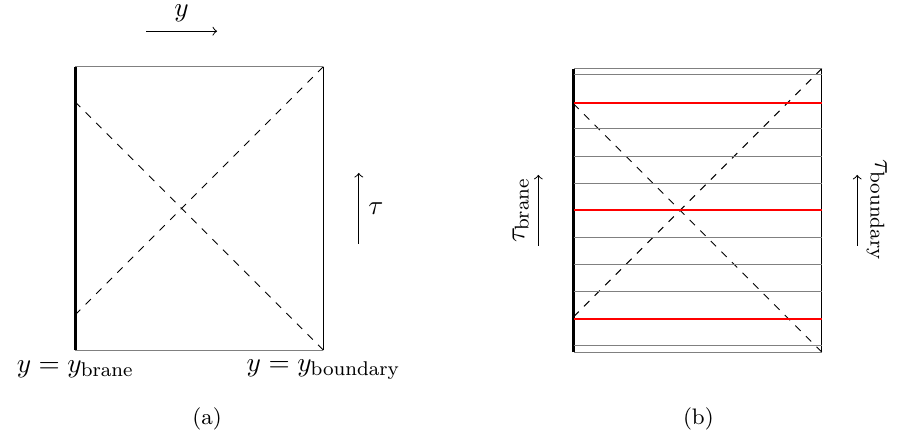
Figure 4 . The Penrose diagram for an AdS 3 black hole microstate with an embedded ETW brane. (a) The asymptotic boundary is located on the right. The ETW brane cuts off the geometry on the left. Horizons are represented by dashed lines. (b) The horizontal lines are extremal surfaces in the connected